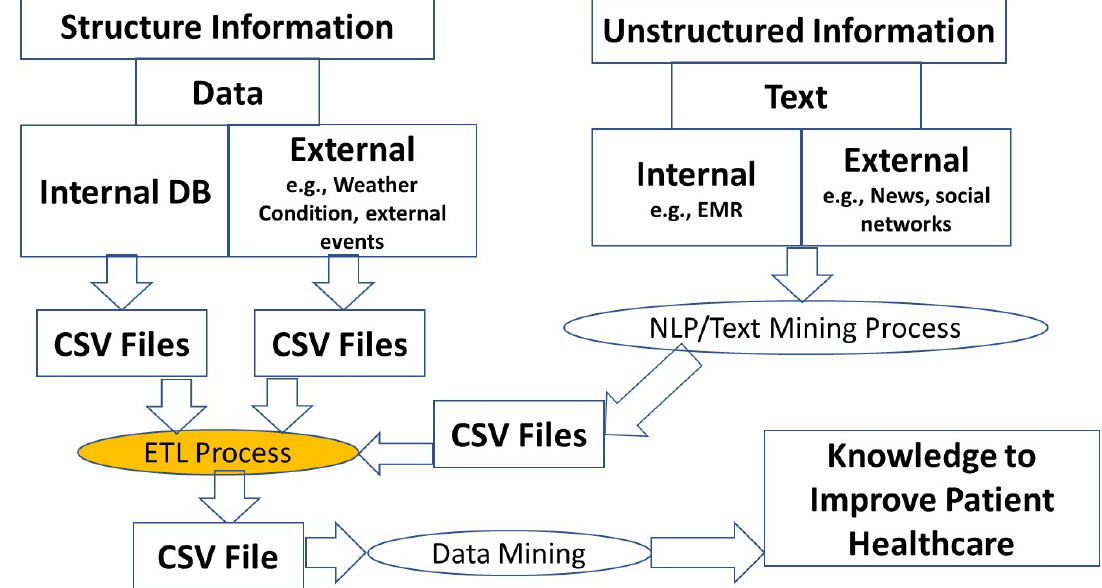
Figure 1. Methodological paths of the research.